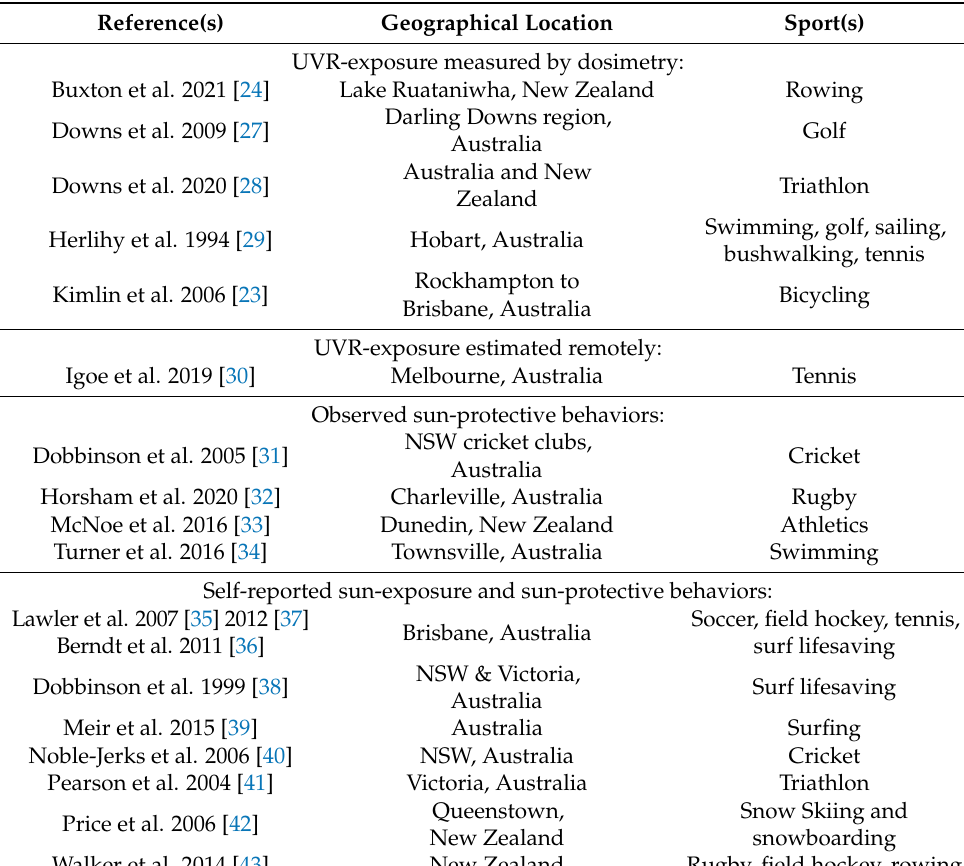
Table 1. Results of search